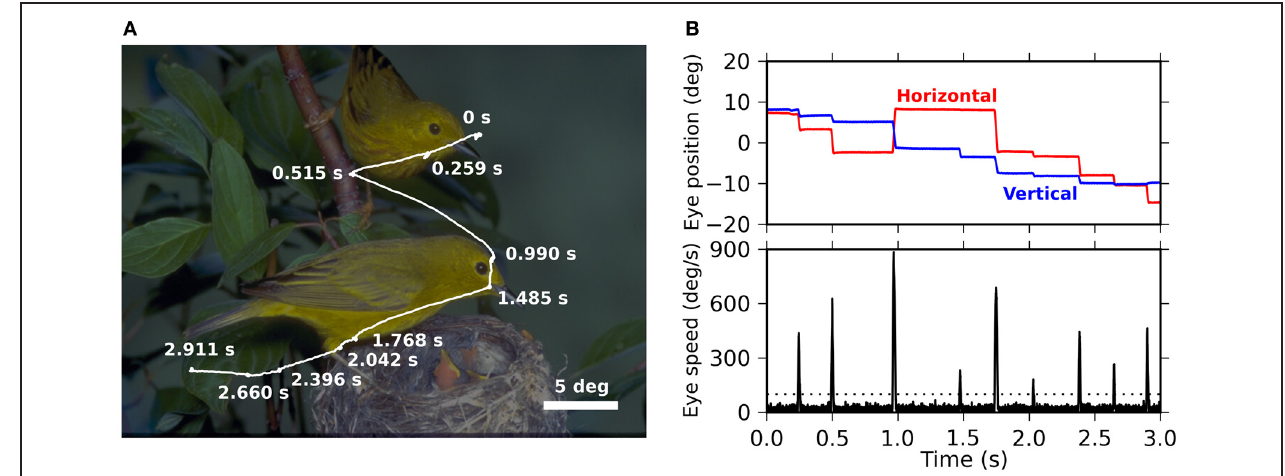
FIGURE 1 | (A) Representative trace of eye movements performed by monkey D during free viewing of a natural-scene image (3s presentation). The trace (white) is superimposed on the presented image, which is darkened for the purpose of a better visibility of the trace. Fixation points, seen as “knots” along the trace, are marked by their onset times measured from the image onset. (B) The top panel shows the time series of the